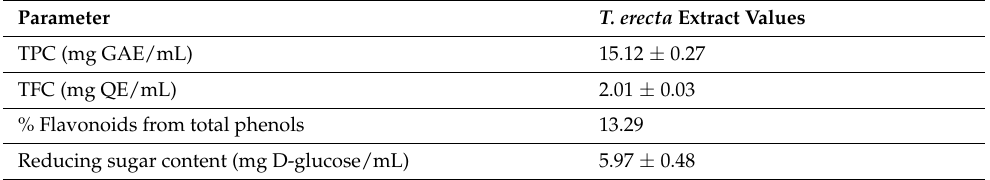
Table 1. The quantification of main class compounds obtained by spectrophotometric methods.